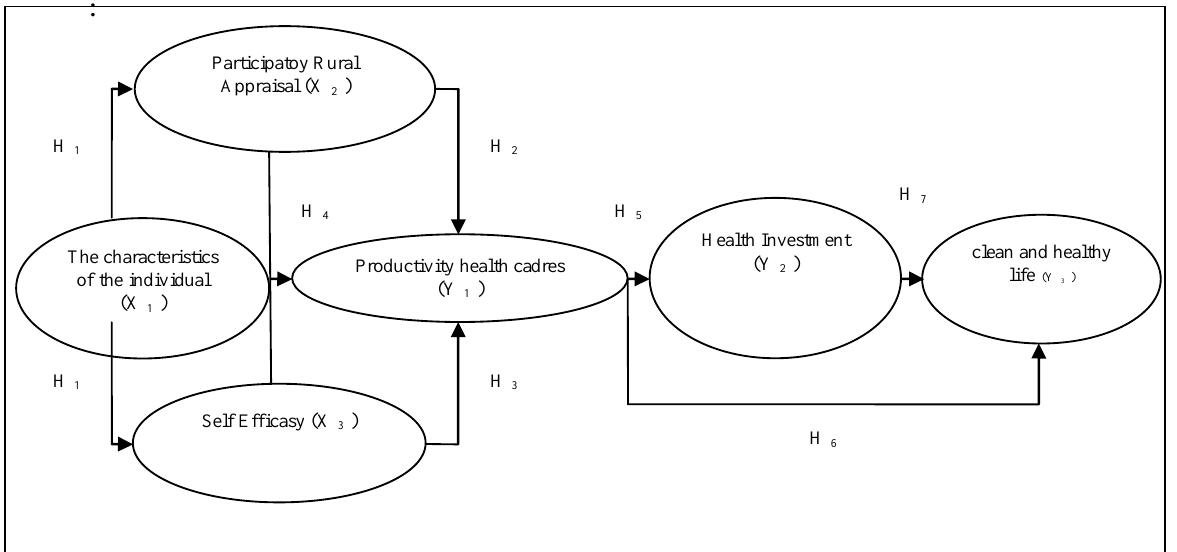
Figure 3. Coefficient Model